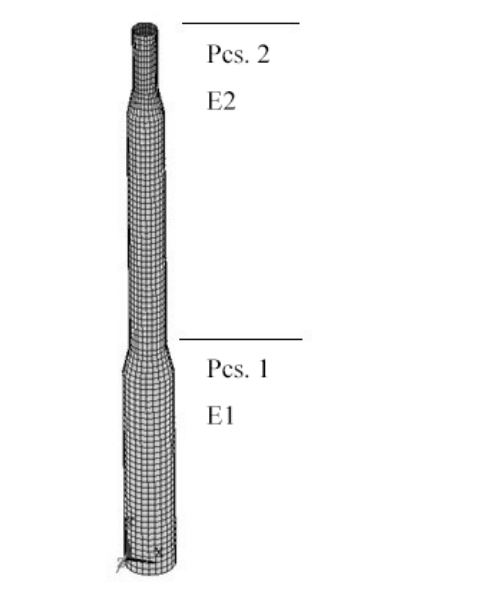
Figure 8. FEM updating